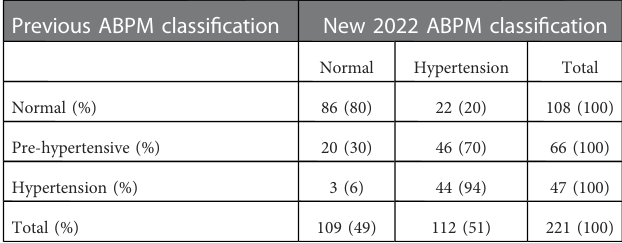
TABLE 2 ABPM diagnoses by the new 2022 criteria vs. the old